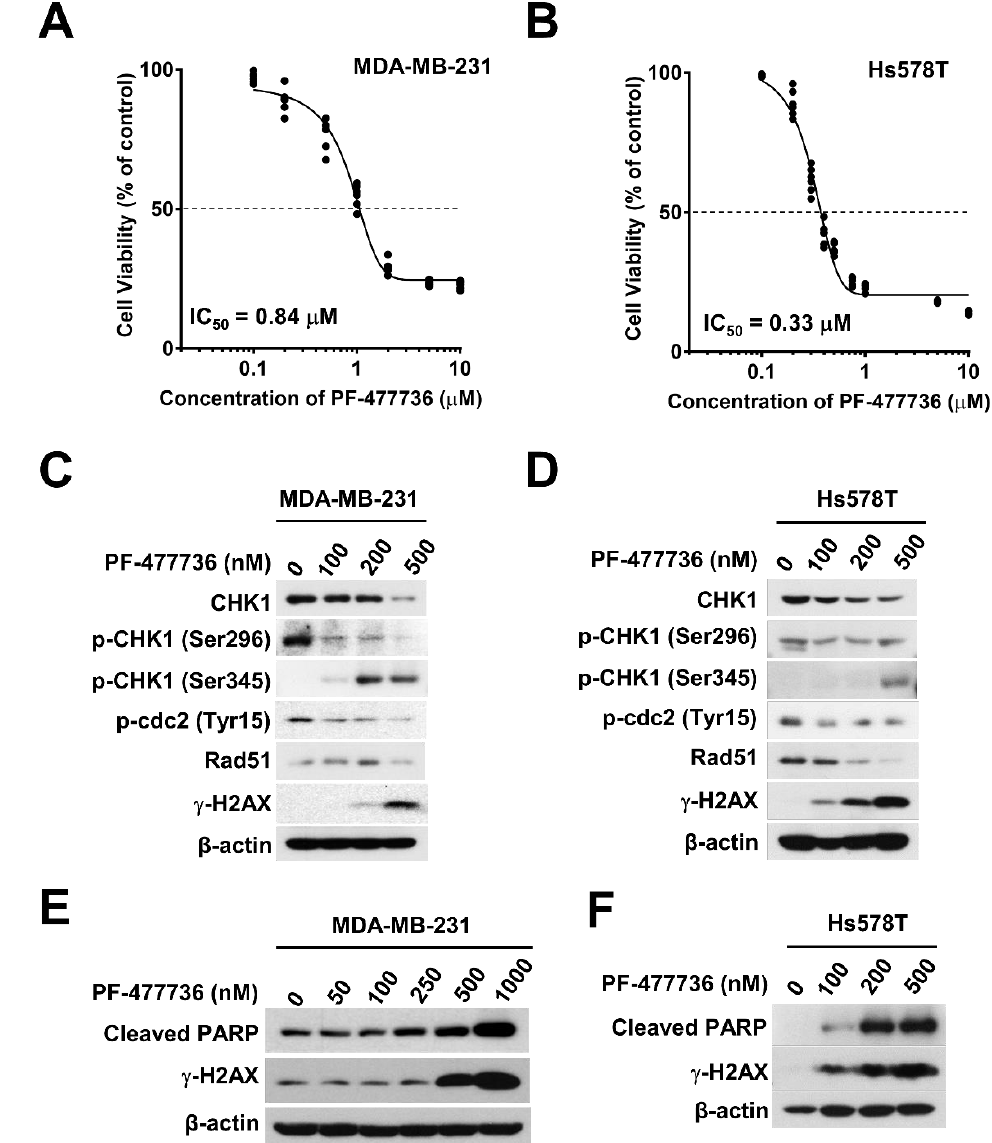
Figure 2. The cytotoxicity of the CHK1 inhibitor, PF-477736 is different in human TNBC cells. Cytotoxic effects of PF-477736 on MDA-MB-231 cells ( A ) and Hs578T cells ( B ). Cell proliferation was measured using the Cell Counting Kit-8 (CCK-8) assay kit after 72 h of PF-477736 treatment. Concentration-dependent inhibition of CHK1 activity in response to PF-477736 treatment in MDA-MB-231 cells ( C ) and Hs578T cells ( D ). Cells were incubated with the indicated concentrations of PF-477736 for 48 h. β-actin was used as a loading control. Concentration-dependent cellular damage in response to PF-477736 treatment in MDA-MB-231 cells ( E ) and Hs578T cells ( F ). Cleaved polymerase (PARP) and γ-H2AX were used as markers of apoptosis and DNA damage. β-actin was used as a loading control.